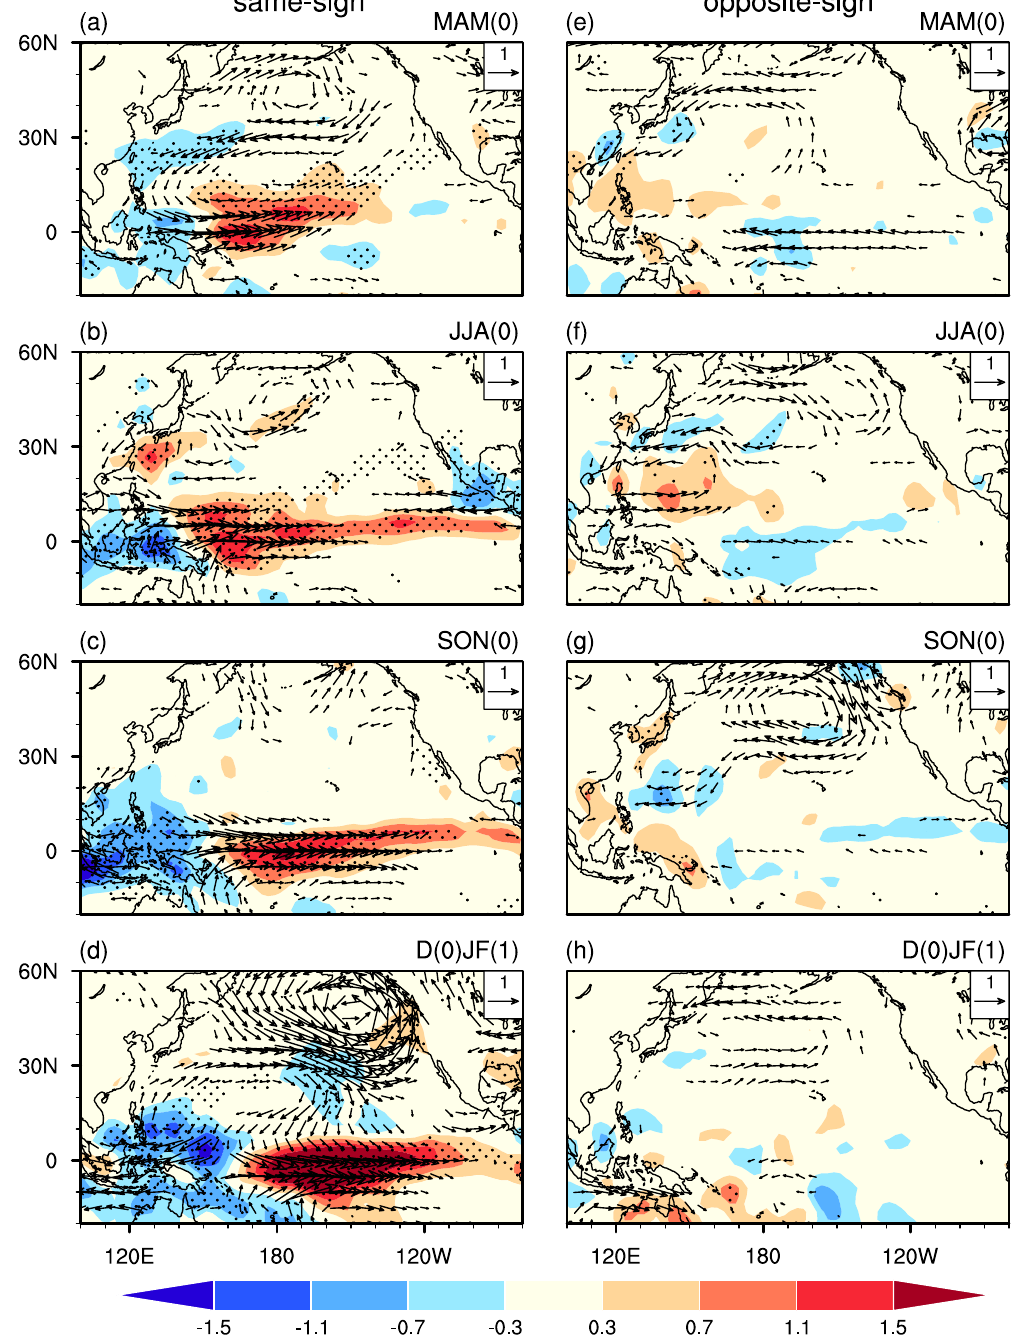
Figure 3. As in Fig. 2, but for 850 hPa winds (m s − 1 , vector) and precipitation anomalies (mm day − 1 , shading). Stippling regions indicate precipitation anomalies that significantly difference from zero at the 95% confidence level. Wind anomalies in both directions less than 0.2 m s − 1 are not